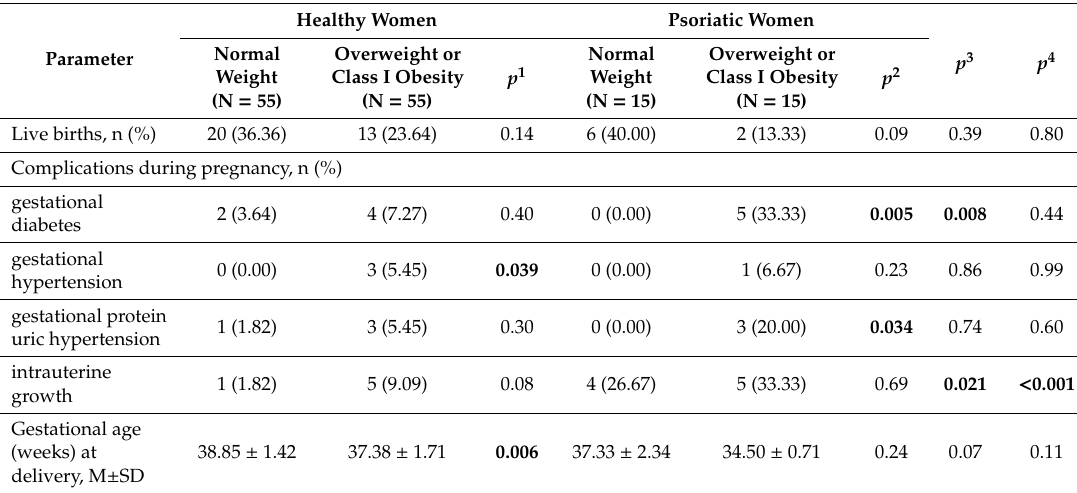
p 1 —normal weight versus overweight or Class I obesity in healthy women. p 2 —normal weight versus overweight or Class I obesity in psoriatic women. p 3 —healthy women with overweight or Class I obesity versus psoriatic women with overweight or Class I obesity. p 4 —healthy women with normal weight versus psoriatic women with normal weight. p for Mann-Whitney’s U test or for chi-square test. Significant di ff erences are in bold. M—mean, SD—standard